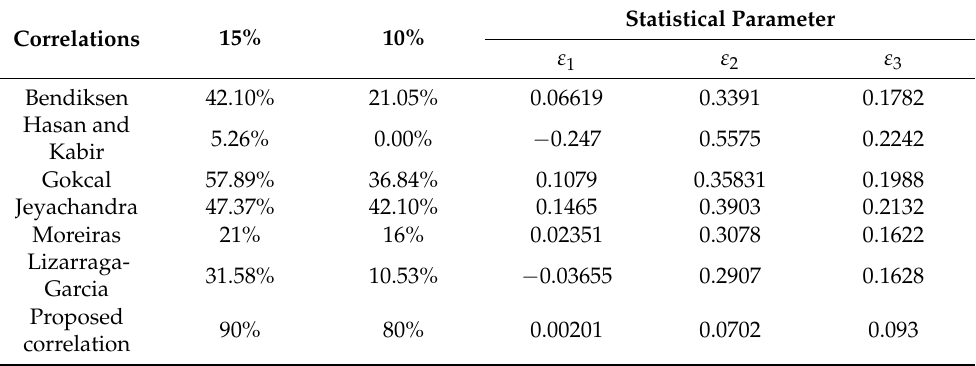
Table 2. The quantitative performance of different correlations against experimental data.